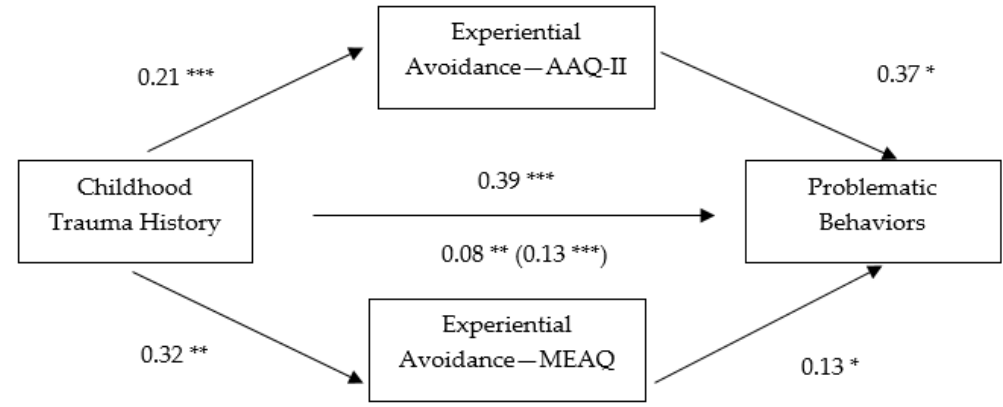
Figure 2. Indirect effect of experiential avoidance (AAQ-II and MEAQ) on the relationship between childhood trauma history and problematic behaviors. Note: * p < 0.05, ** p < 0.01, *** p < 0.001. Path values were drawn using unstandardized regression coefficients. Parentheses indicate the total